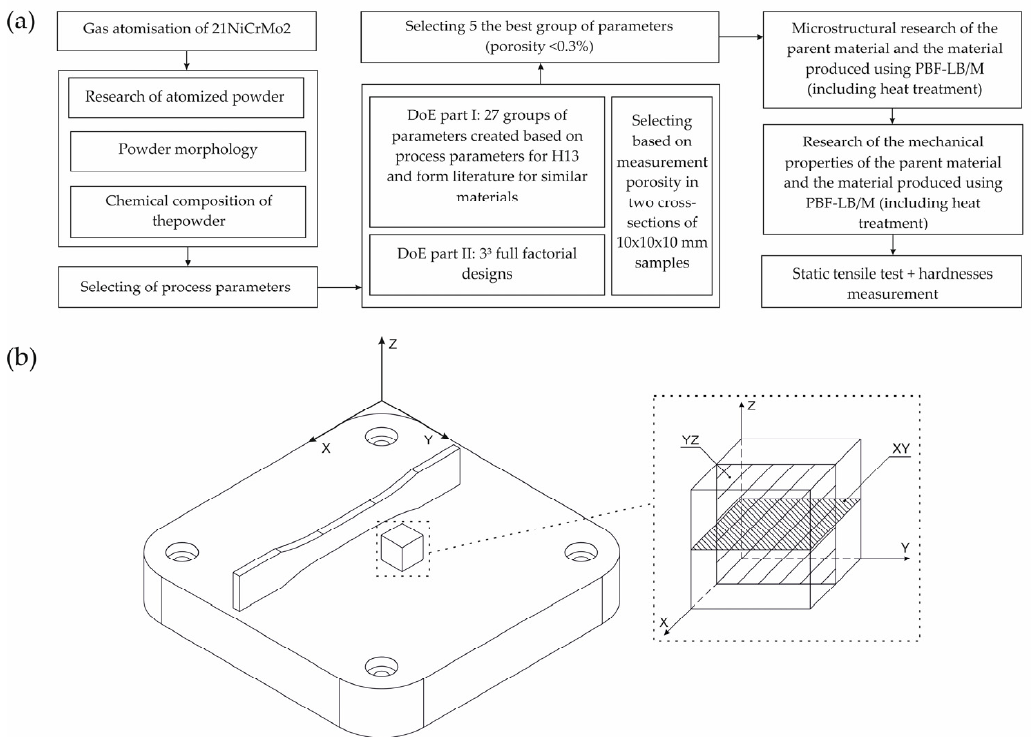
Figure 2. ( a ) Flowchart of the adopted research methodology and ( b ) the orientation of samples orientaton in the substrate plate of SLM 125HL (Z—the direction of the layers’ deposition).